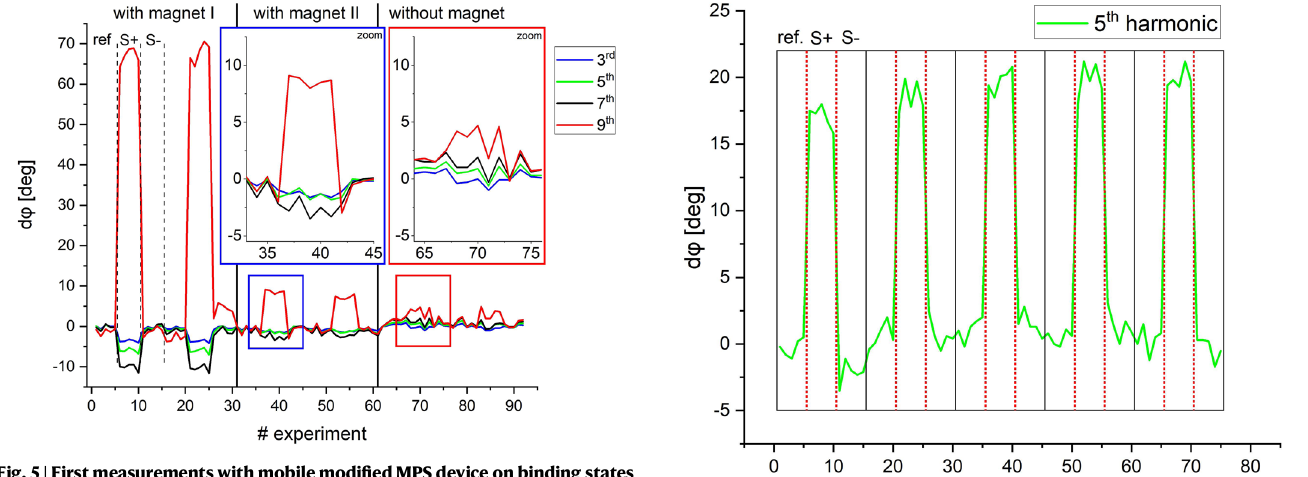
Fig.5|Firstmeasurementswithmobilemodi fi edMPSdeviceonbindingstates on MNP-APTES-S1. Comparison of signals with and without offset magnetic fi elds (gradient fi eld). All sequences show 5 experiments with reference sample ( ref ), 5 with binding sample ( S +) and 5 with non-binding sample ( S − ) repeated two times. With magnet I The signal (phase difference) is clearly visible. With magnet II The rotated magnet yields a lower magnetic fi eld resulting in a signal loss. Without magnet The signal almost vanishes without any external magnetic offset or mag- netic gradient fi eld. For all experiments, nanoparticles ligated with the SPIKE (S1) protein of the SARS-CoV-2 virus with an antibody dilution of 1:10,000 was used.